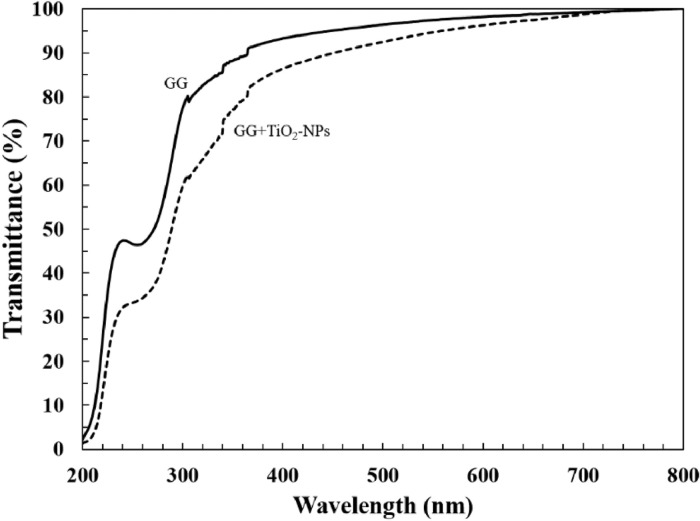
UV–Vis spectra of GG and GG+TiO2-NPs biofilms.